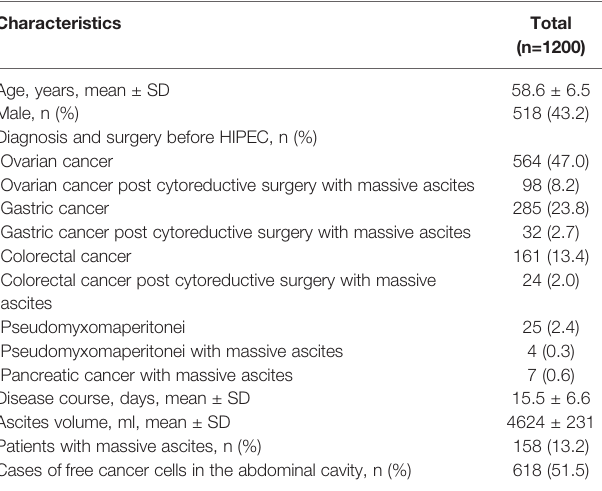
TABLE 1 | Characteristics of the